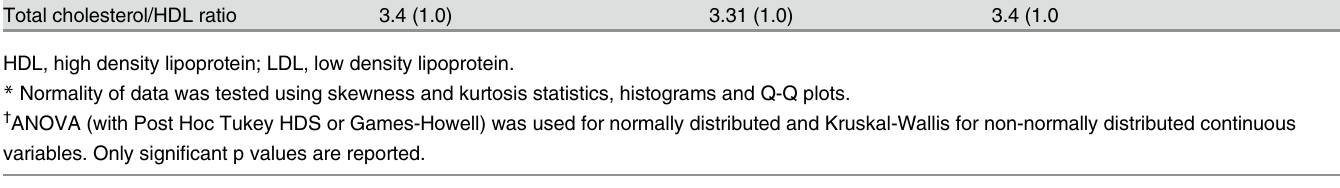
* Normality of data was tested using skewness and kurtosis statistics, histograms and Q-Q plots. † ANOVA (with Post Hoc Tukey HDS or Games-Howell) was used for normally distributed and Kruskal-Wallis for non-normally distributed continuous variables. Only signi fi cant p values are